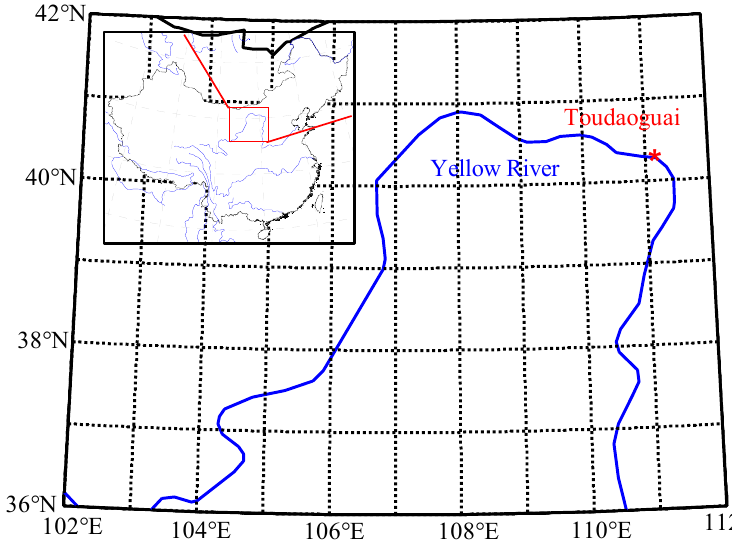
Figure 1. Location of our study area within the Toudaoguai cross-section of the Yellow River.